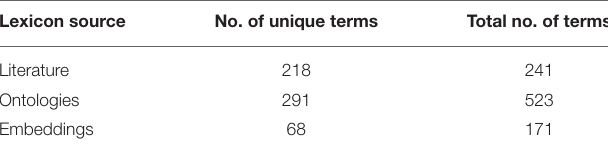
TABLE 7 | Lexicon